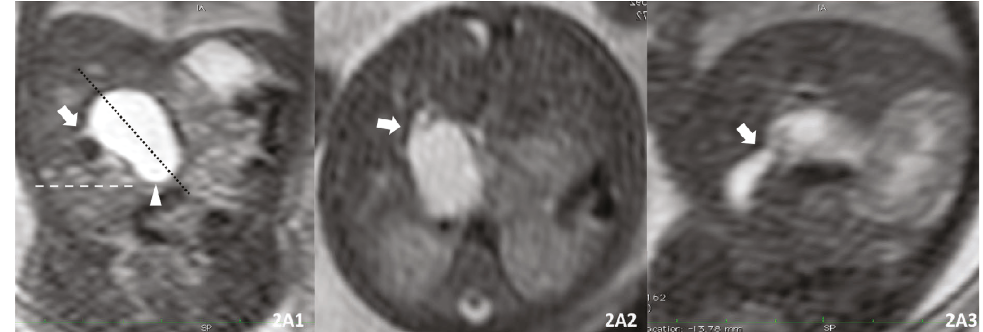
Figure 2: Signs of the CDC ∗ (Case 11, G29+W). Sign A: the cyst was located at the porta hepatis. Sign B: the end of the cyst is higher than the lowest edge of the liver (white dotted line). Sign C: parallel to the hepatoduodenal ligament (dark dotted line). Sign E: the cyst was connected to the gallbladder/duct of gallbladder (white arrow). Tapper sign (white triangle). ∗ CDC: choledochal cysts.